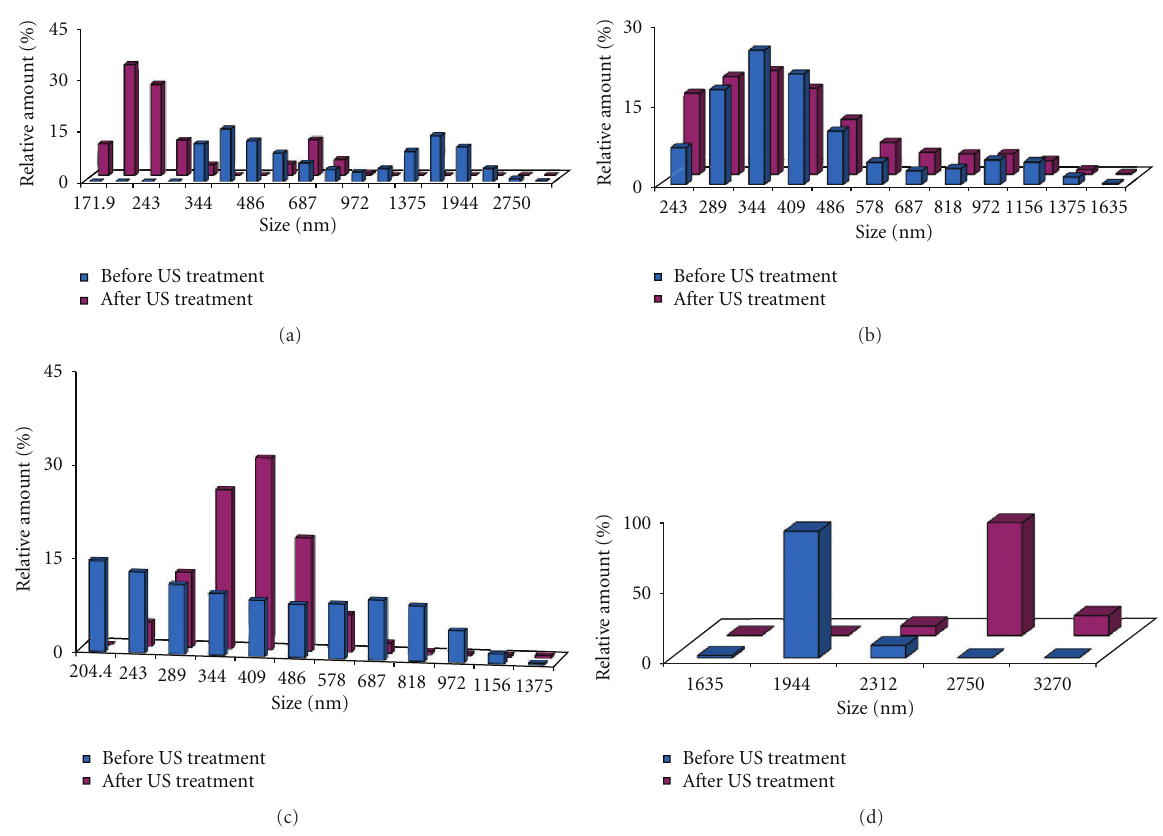
Figure 1: Number-weighted size distribution in the blend solutions before and after sonication: CPL1/130 ◦ C in CHCl 3 (a), CPL1/130 ◦ C in mixed solvent (CH 2 Cl 2 /DMSO of 9/1v/v) (b), CPLG/60 ◦ C (c), and CPL2/100 ◦ C (d) both in CHCl 3